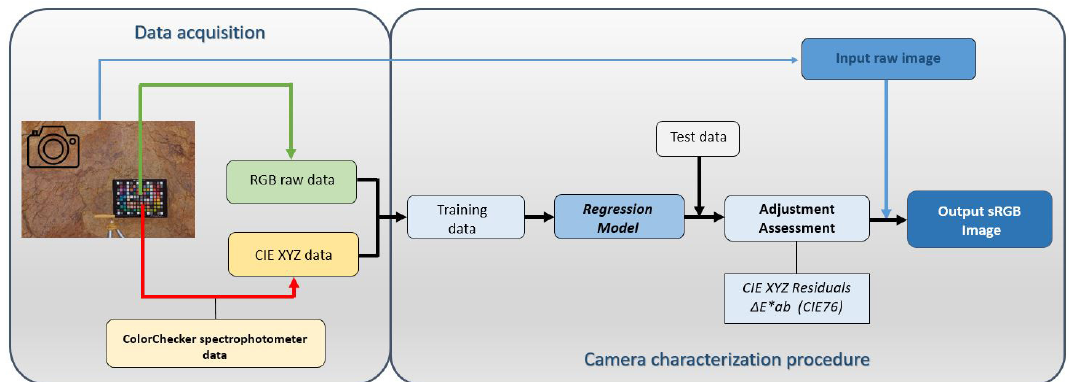
Figure 1. Schematic diagram designed for the camera characterization.